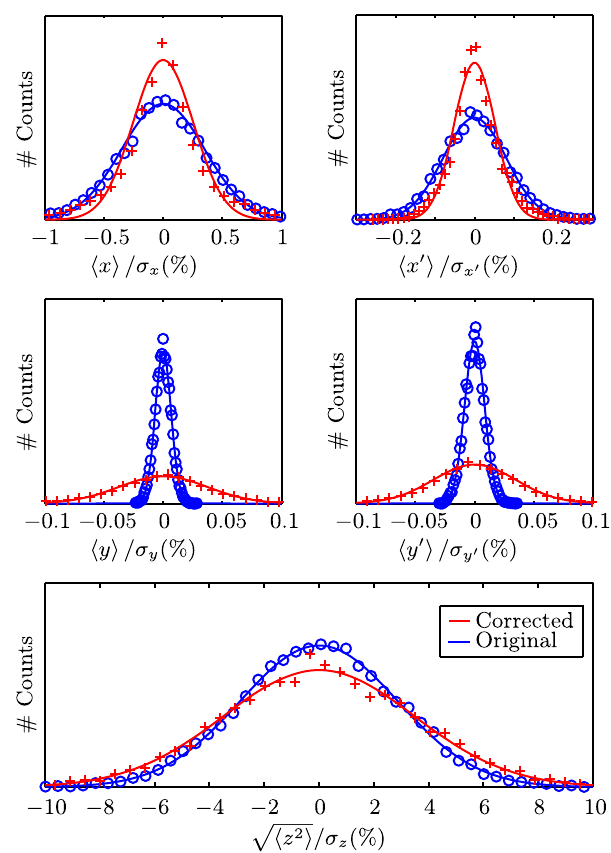
FIG. 6. 10 ’ 000 jitter runs with (red) and without (blue) beam tilt correction. The additional orbit jitter originating from the leaking dispersion is minimal and is well within tolerances of SwissFEL. The points correspond to the actual data points and the lines correspond to Gaussian